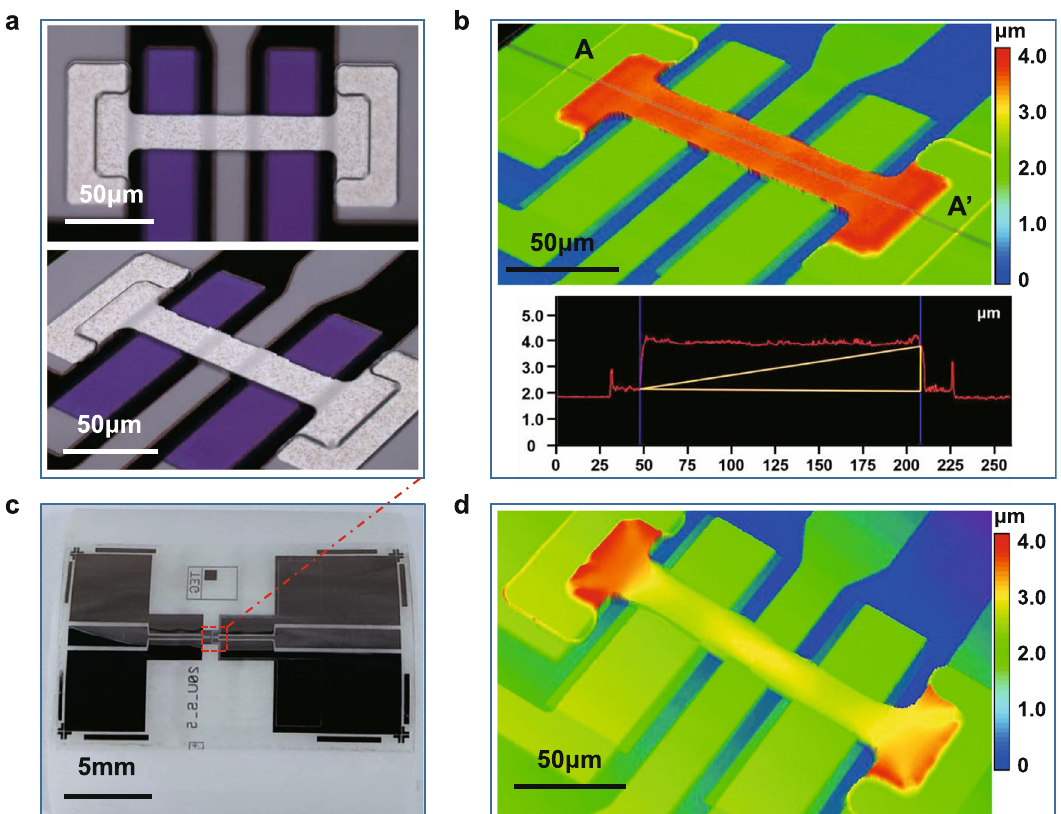
Fig. 3 Illustrations of fabricated fl exible RF MEMS switch for characterization. a Optical microscope top view and oblique view of fl exible RF MEMS switch. b Oblique view of 3D surface topography contour of fl exible RF MEMS switch membrane beam. c Photograph of the fl exible RF MEMS switch device bent on a curved surface. d Oblique view of 3D surface topography contour of fl exible RF MEMS switch in membrane beam driving state. (Membrane beam width: 20 μ